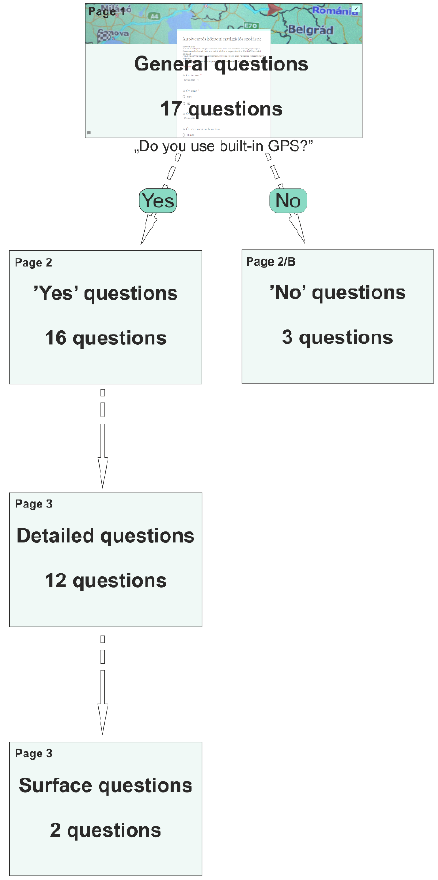
Figure 2. Structure of the online questionnaire. Table 1. The questions elaborated for this paper, and the number of respondents for each country.